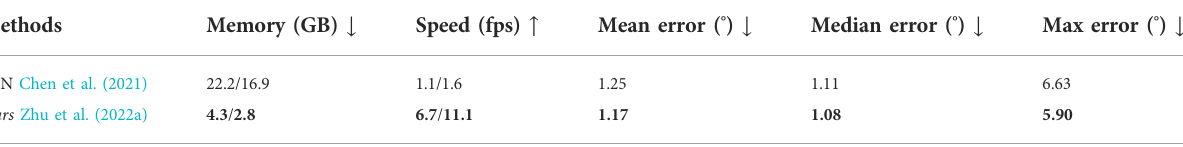
TABLE 6 Experiment result of pose estimation on ModelNet40 data set (Wu et al., 2015) on the plane category. Two numbers are shown for GPU memory consumption and running speed for training/inference separately, given the same input size for two methods. Notice that the numbers are not directly comparable to Table 5 due to different experiment settings.